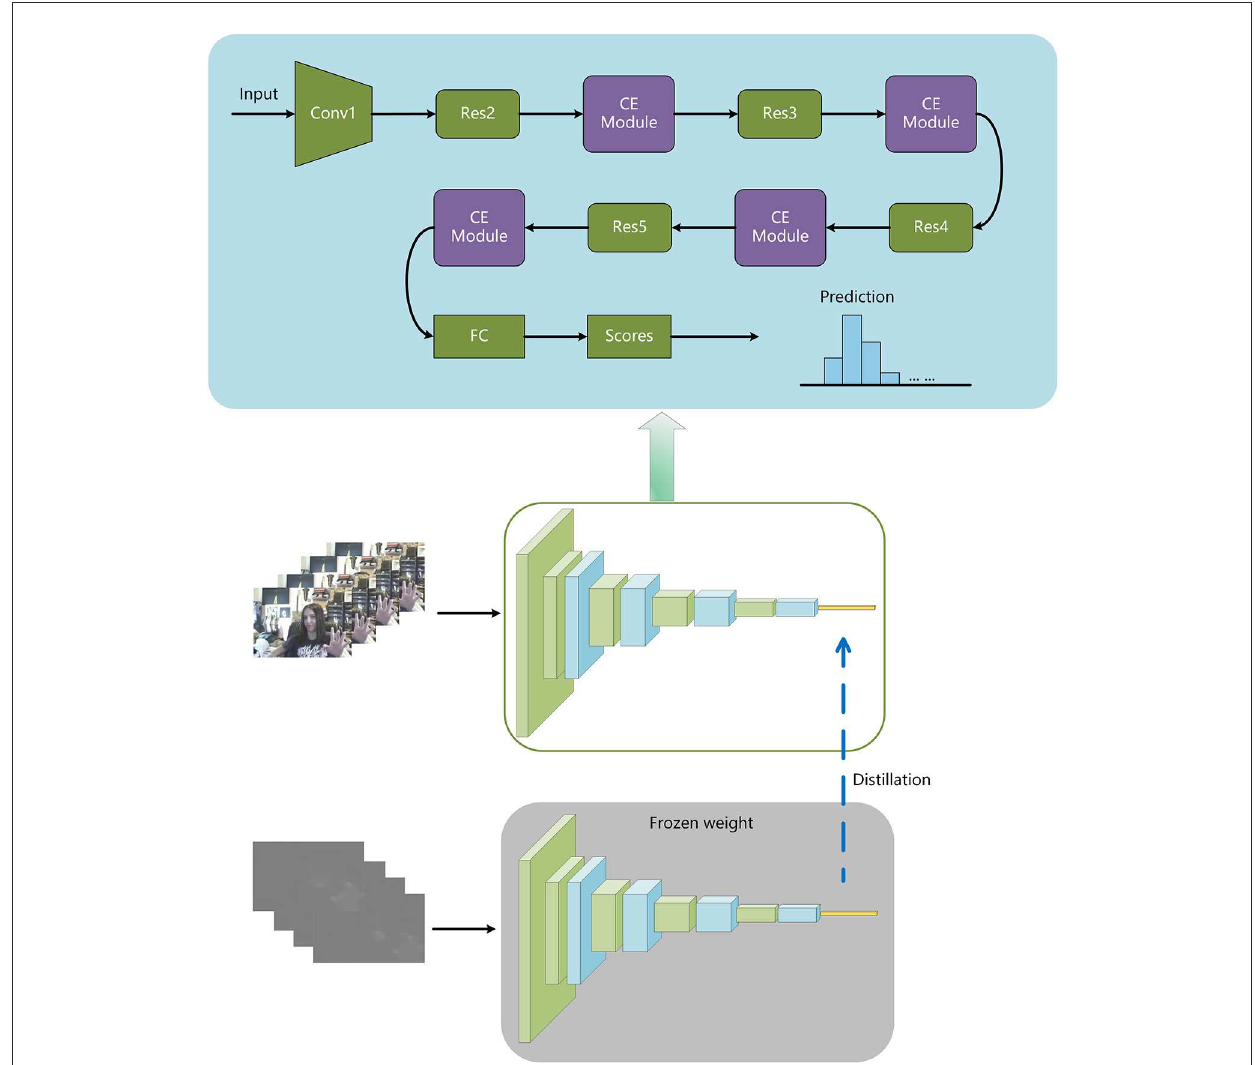
FIGURE1 Training to make use of motion and appearance data. Initially, we use optical flow clips with cross-entropy loss to train the flow stream to identify activities and then freeze its weights. IMRS exploits both motion and appearance information by backpropagating the linear combination loss between features’ overall network